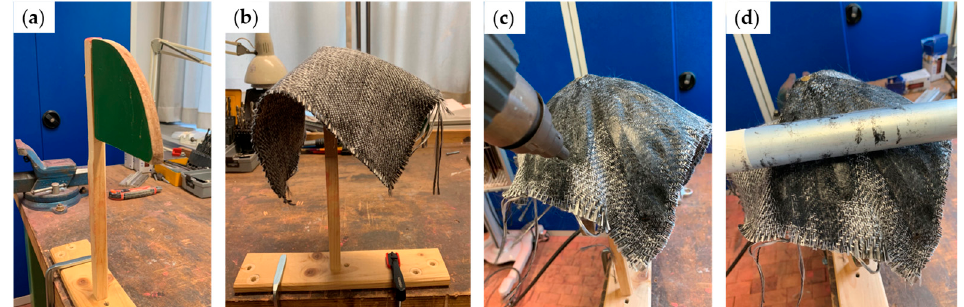
Figure 16. ( a ) 2D quarter circle tool attached to pole; ( b ) Commingled yarn weave affixed to pole; ( c ) Heating of the fabric with a hot air gun; ( d ) Roller tool used for forming and consolidation [45].